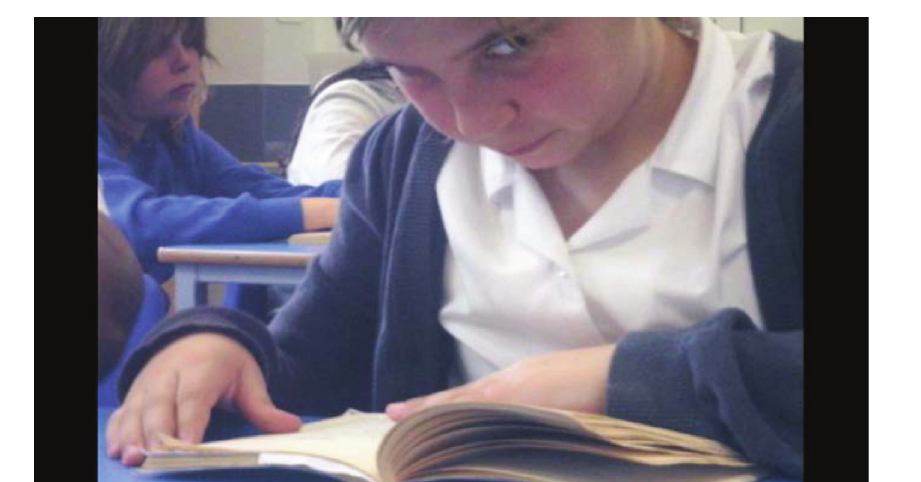
Figure 9: Arwyn hatches a cruel